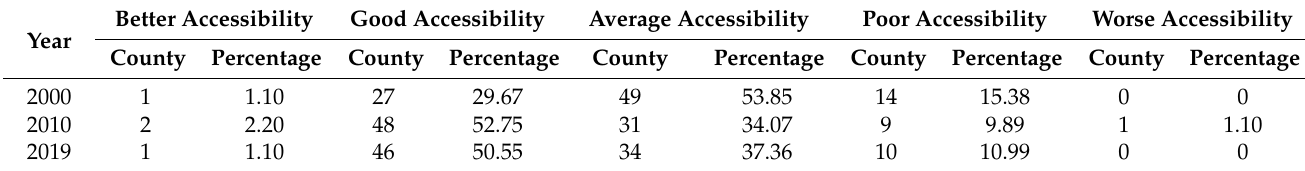
Figure 2. Distribution of the average accessibility of educational facilities in the YGGRD. Table 3. Accessibility grading statistics of educational facilities under different accessibility types.